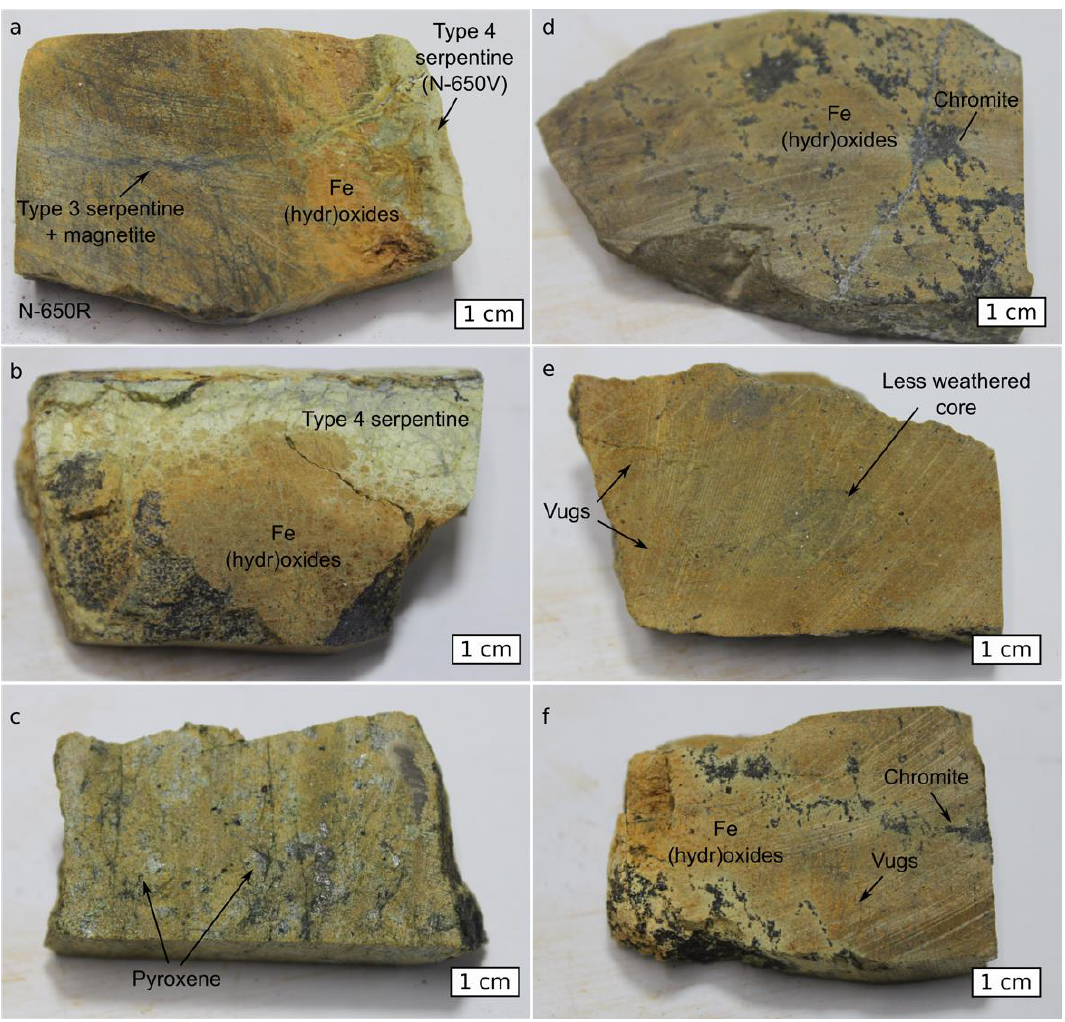
Figure 3. Saprolite samples in hand specimen. ( a ) Sample N-650R showing black serpentine–magnetite veins (type 3) being altered into light-green serpentine (type 4, N-650V). ( b ) Sample N-1100, heavily altered saprolite sample with a garnierite vein (type 4). Note that the serpentine vein ema- nates from what appears to be boundaries of relict grains. ( c ) Sample N-1050, least altered saprolite sample showing pyroxene crystals about 2–3 mm in size. ( d ) Sample N-690, containing unaltered chromite disseminated in a matrix of strongly weathered Fe (hydr)oxides. ( e ) Sample N-850, heavily weathered sample with a less altered core. Small dissolution vugs later filled by Fe hydr(oxides) are also present. ( f ) Sample N-1000, showing unaltered disseminated chromite in an Fe hydr(oxide) weathered matrix. Dissolution vugs are also present.